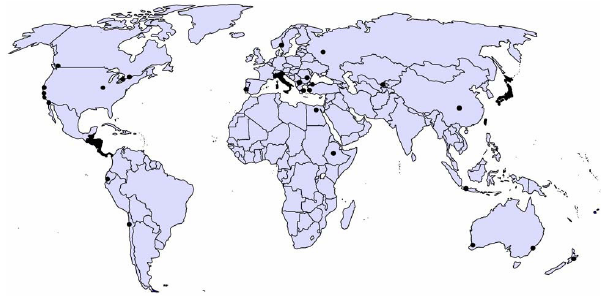
1 Figure 4. The following are the test regions used by the software packages reviewed (with the 2 Fig. 4. Test regions used by the software packages reviewed (with exception of QLARM and PAGER which are globally produced) 3 the exception of QLARM and PAGER which are globally pro-